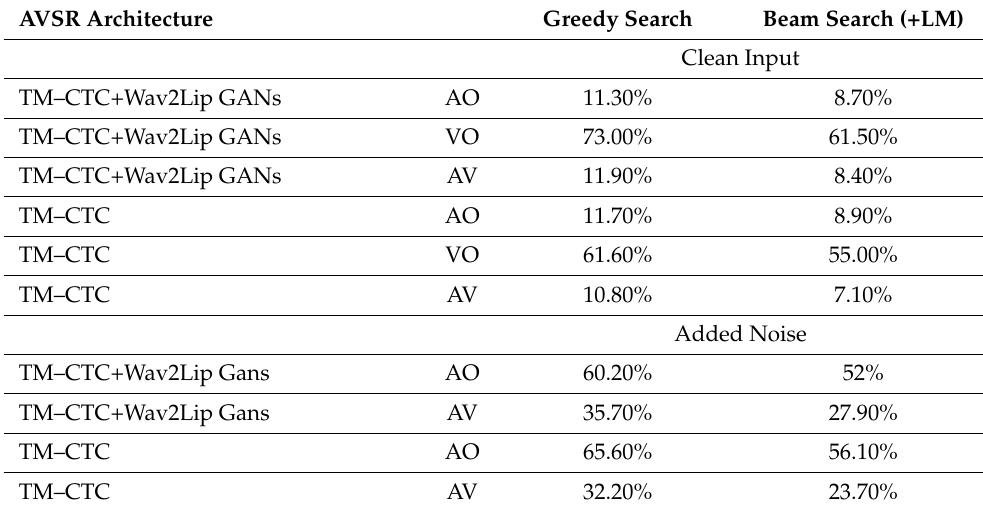
Table 2. Audio-only (AO), visual-only (VO) and audio-visual (AV) results of word-error rate (WER) tested on LRS2 dataset.